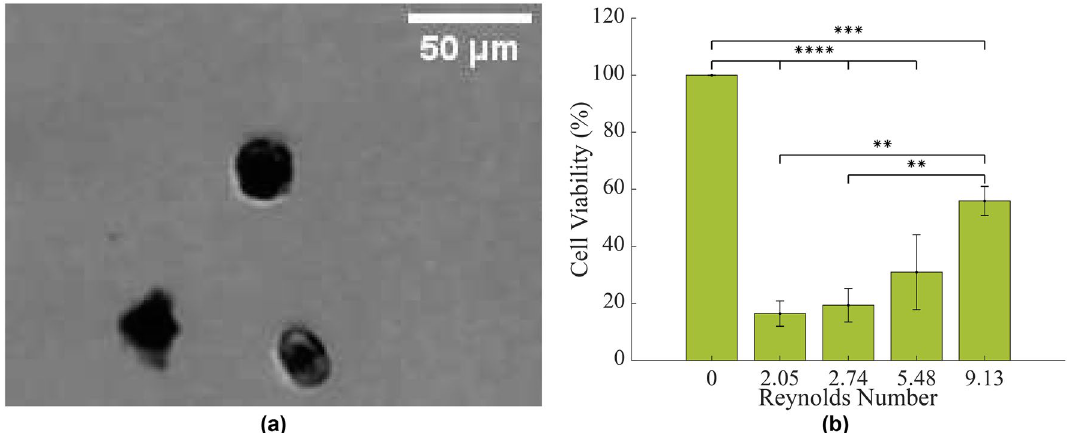
Figure 3. (a) Primary fibroblasts following suspension in Poiseuille flows of Re = 5.48 for 24 hours, stained with trypan blue. (b) The viability of primary intestinal fibroblasts in circulation, assessed using MTT assay. Statistical analysis was conducted using two-way ANOVA. Results were normalised to static cells in suspension (or Re of 0). **** p < 0.0001, *** p < 0.001, ** p < 0.01, n = 3 replicates, vertical bars represent the